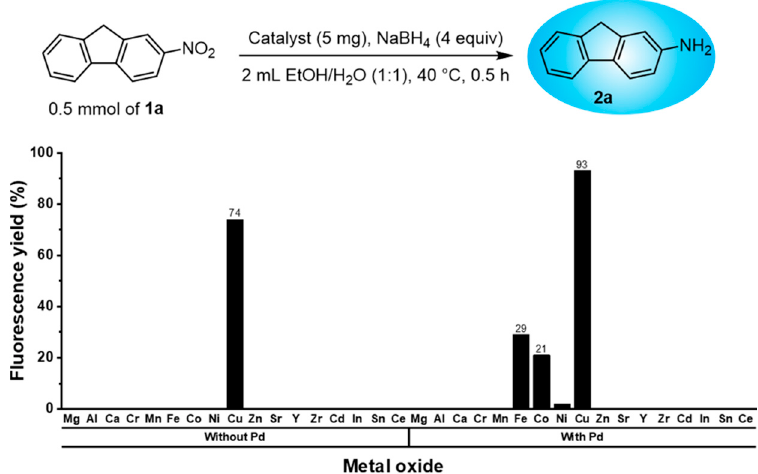
Figure 1. Results of the first screening of the catalytic activity of metal oxides.